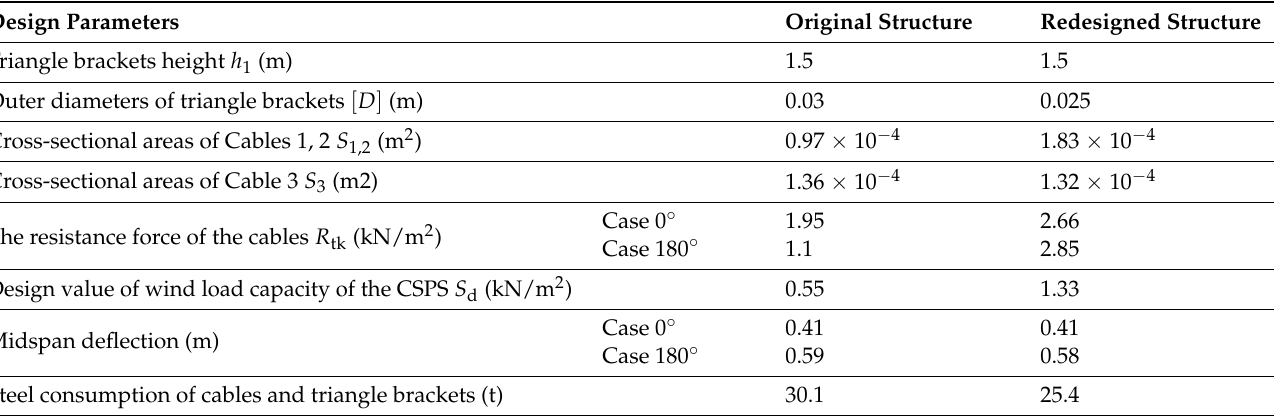
Table 5. Comparison of parameters between the original structure and the redesigned structure per